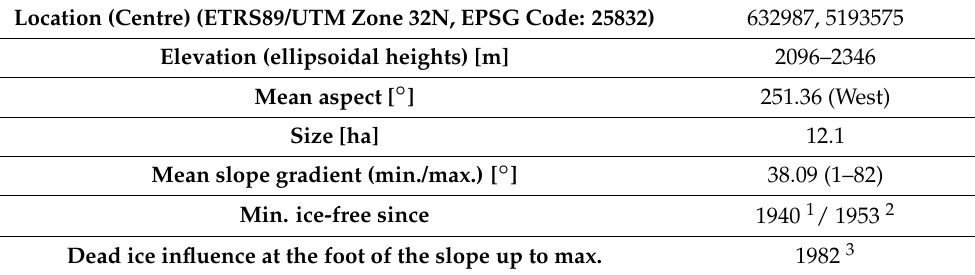
Table 1. Characteristics of the Area of Interest (values were derived from 2017 DEM).